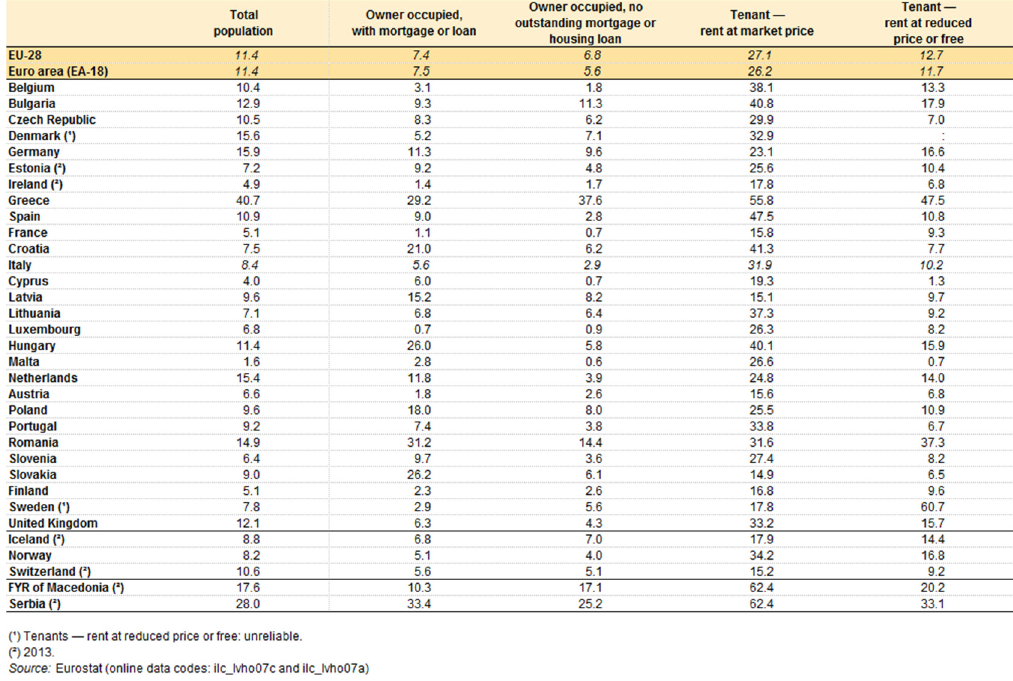
Figure 3 . Housing cost overburden rate by tenure status, 2014, % of population. Source: Eurostat [50] © European Union, 1995–2013.